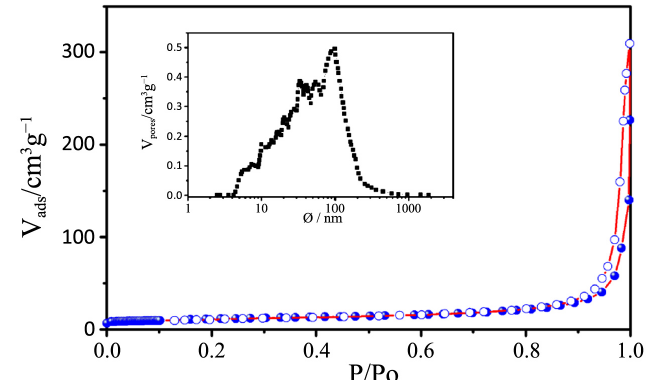
Figure 10. N 2 physisorption isotherms of P25. The pore size distribution is depicted in the insert figure.